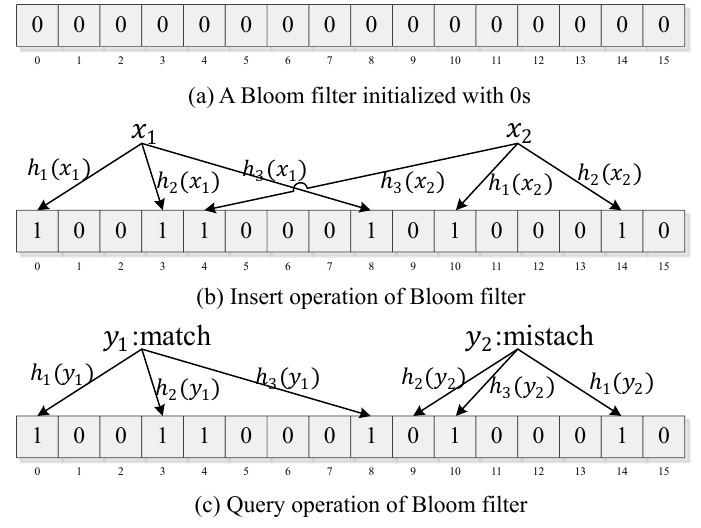
Figure 2. Example of Bloom